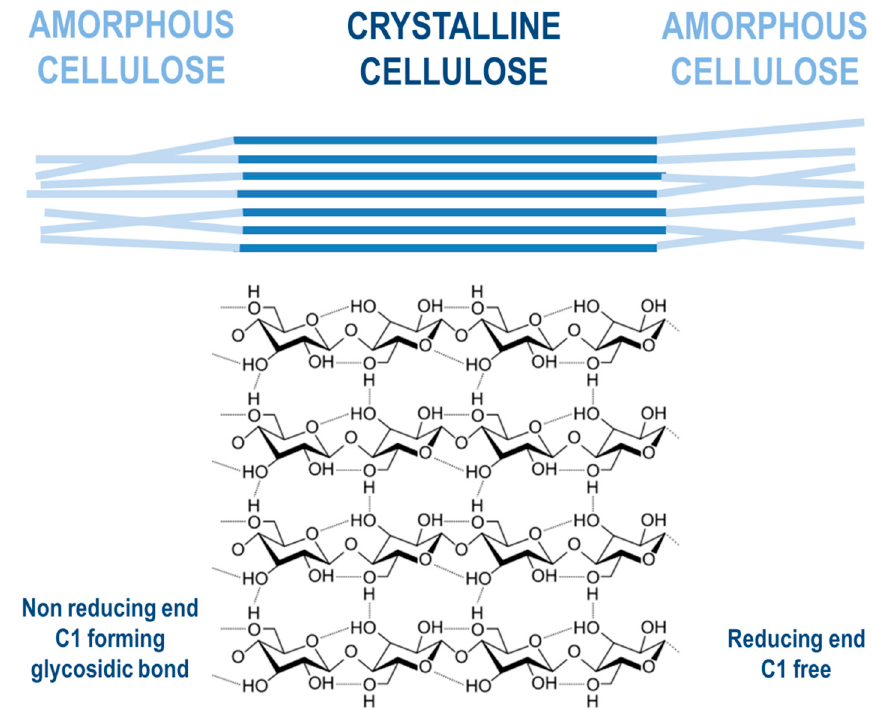
Figure 5. Cellulose